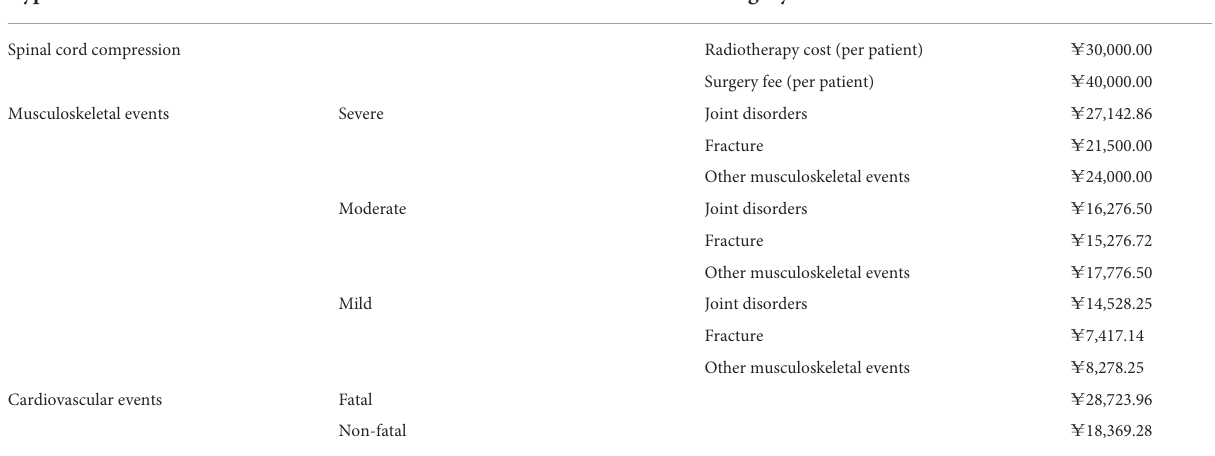
TABLE 6 Cost of adverse event management. Types of adverse